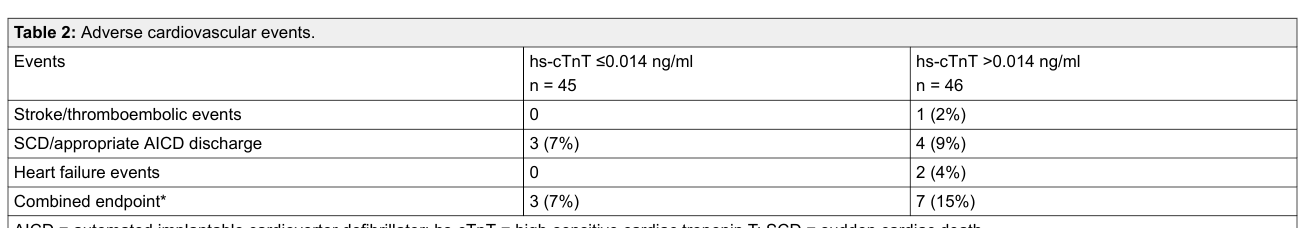
Table 2: Adverse cardiovascular